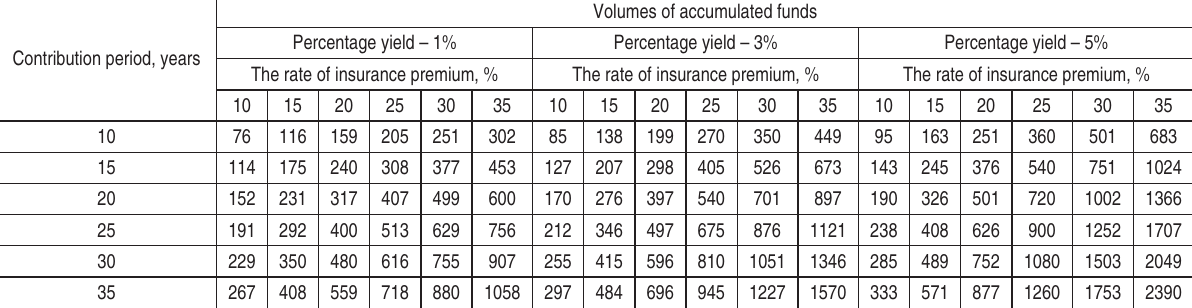
Table 2. The amount of accumulated funds in the accumulative pension